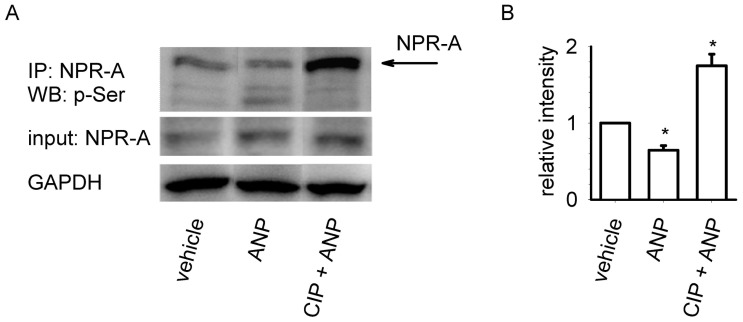
Pretreatment with CIP inhibits dephosphorylation of NPR-A.(A) A representative experiment demonstrating that treatment of MA-10 cells with 10 nM ANP caused a reduction in p-Ser content. Pretreatment with CIP substantially augmented NPR-A phosphorylation. (B) Quantitation of NPR-A phosphorylation demonstrates that pretreatment with CIP caused a two-fold increase in the relative intensity of p-Ser labeled bands from ANP-treated MA-10 cells. Experiments were conducted in the presence of 500 µM IBMX. * P<0.05. Data are representative of three experiments.